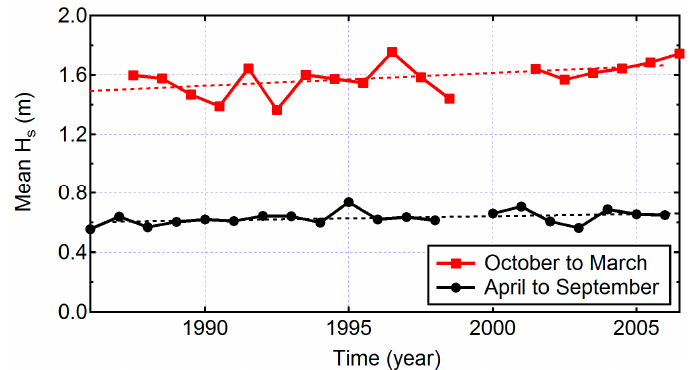
Figure 6. Seasonal variation of shoreline location.